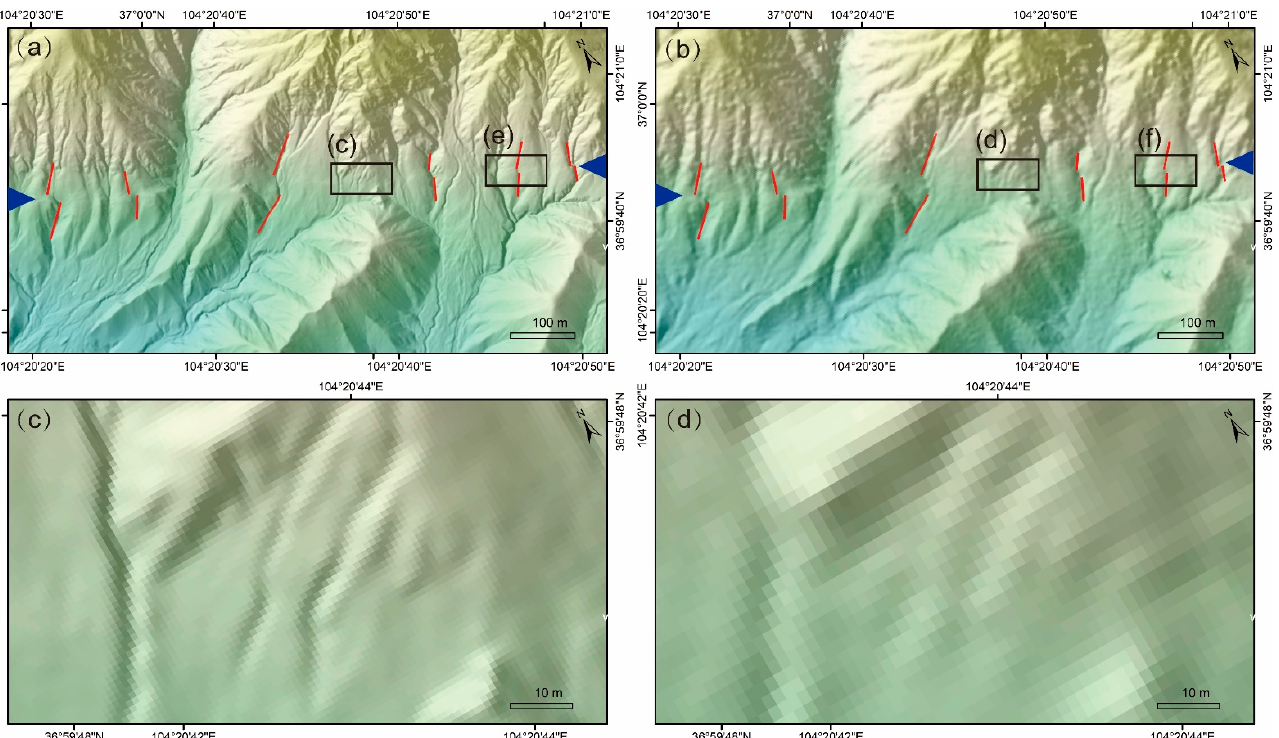
Figure 11. The fault features identified by the airborne LiDAR-derived DEM with a 1 m resolution ( a , c , e , g ) and GF-7 DEM with a 2 m resolution ( b , d , f , h ). The blue triangles represent the faults iden- tified. 4.3. Comparison of the Measurements of the Vertical Offsets Figure 12 shows the vertical offsets of V1~V8 measured by the airborne LiDAR-de- rived DEM, GF-7 DEM Method1 , GF-7 DEM Method2 , and GF-7 DEM Method3 . The GF-7 DEMs could reconstruct the fault profile shape with a scarp height larger than 2 m, but signifi- cant errors could be observed in the fault profile shape reconstructed by the GF-7 DEMs for small vertical scarps, such as V6 and V8. Figure 13 represents the error scatterplot be- tween the vertical offsets extracted from the airborne LiDAR-derived DEM and the three different GF-7 DEMs. The bias and RMSE values of the vertical offsets measured by GF-7 DEM Method1 were –0.32 m and 0.55 m. Compared with the significant error in the elevation of GF-7 DEM Method1 (RMSE = 110.58 m), the accuracy of the vertical offsets measured by GF-7 DEM Method1 improved significantly, indicating that the absolute elevation error of GF- 7 DEM Method1 was large while the relative elevation error was small. The RMSE and bias values of the vertical offsets measured by GF-7 DEM Method2 were the same as or smaller than those of GF-7 DEM Method1 . Among these three GF-7 DEMs, the accuracy of the vertical offsets measured by GF-7 DEM Method3 is the highest, with a bias value of –0.19 m and an RMSE value of 0.41 m. This means that the GCPs extracted from ICESat-2/ATLAS data can slightly improve the accuracy of the measurements of the vertical offsets.